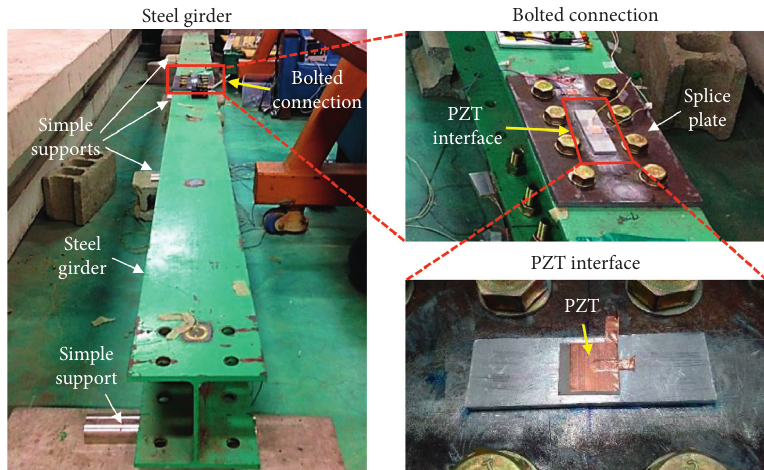
Figure 4: Setup of lab-scaled girder